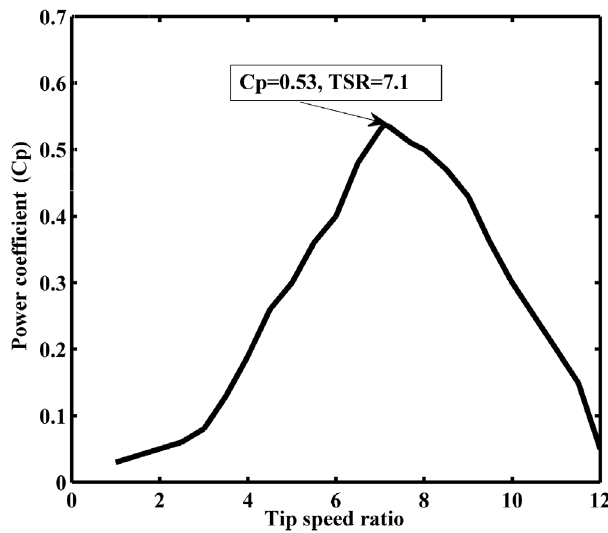
Figure 10. Performance curve of 4 kW Small Wind